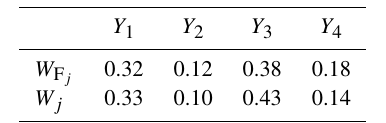
Table 2. Fuzzy ( W F hazard